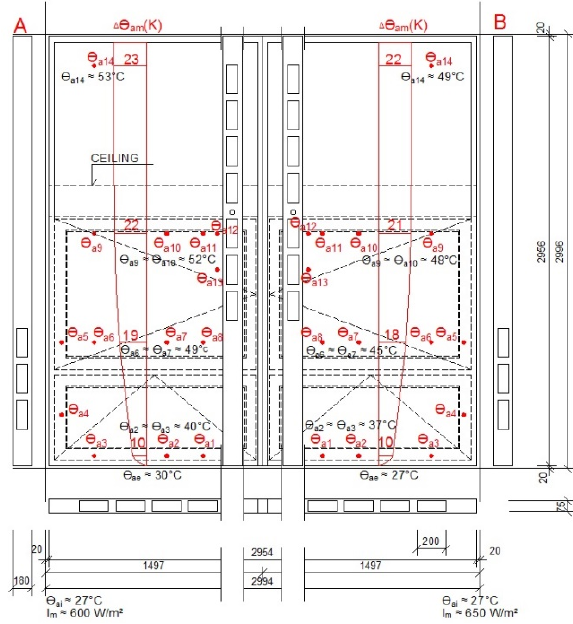
Figure 19: Scheme of air movement in the cavity of a double facade A - windows of the inner wall of the double facade open B - windows of the inner wall of the double facade closed.